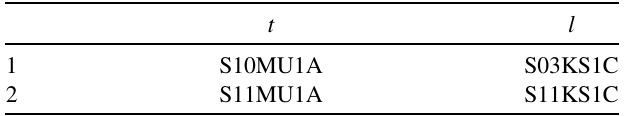
TABLE II. Elements of SIS18 used for the first proof of principle experiment.